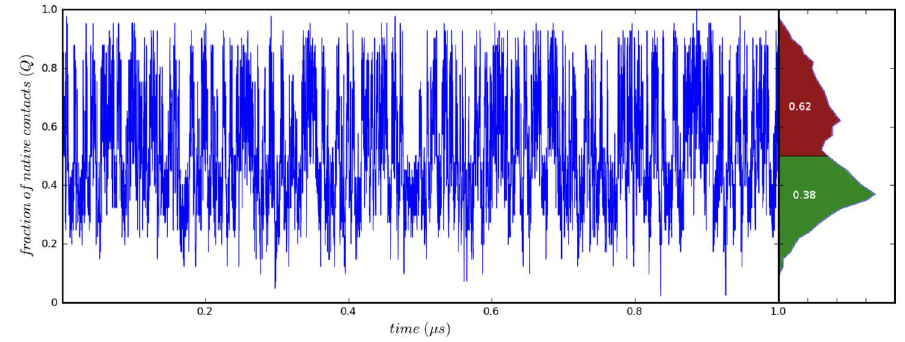
Figure 2. An example trajectory. The fraction of native contacts are plotted as a function of time. By inspecting the histogram at the right, we observe that this trajectory was simulated below T m , as the protein is folded for 62% of the simulation.